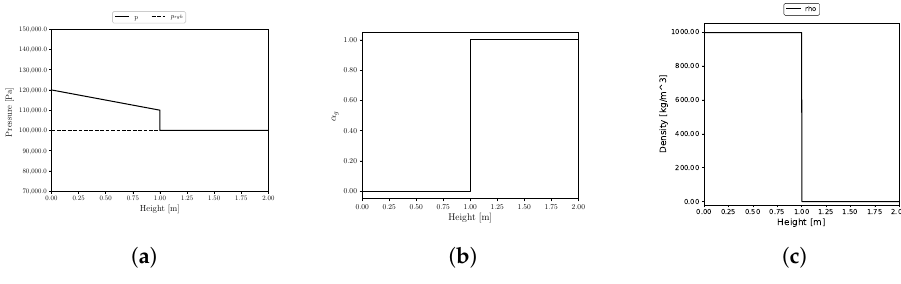
Figure 12. Initial flow conditions; ( a ) pressure; ( b ) α nc ; ( c ) density. Monitored benchmark quantities are the overall mass conservation and the instanta- neous mass balance between the liquid fuel and the fuel vapor. 1.